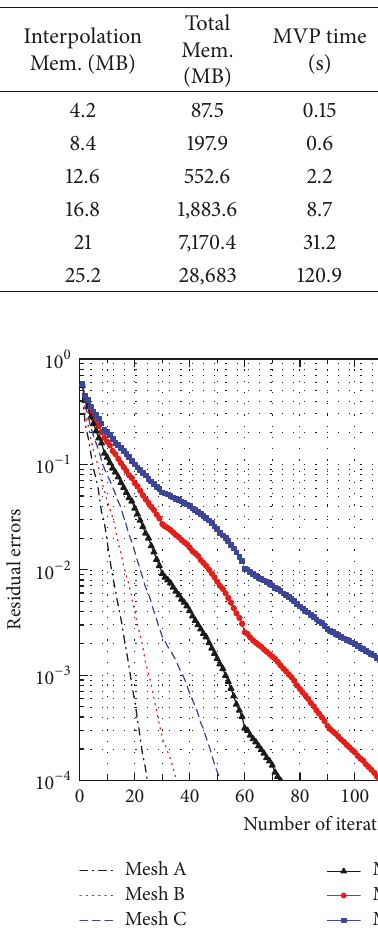
Table 1: Computational statistics of the PEC cube with different meshes at 300MHz.